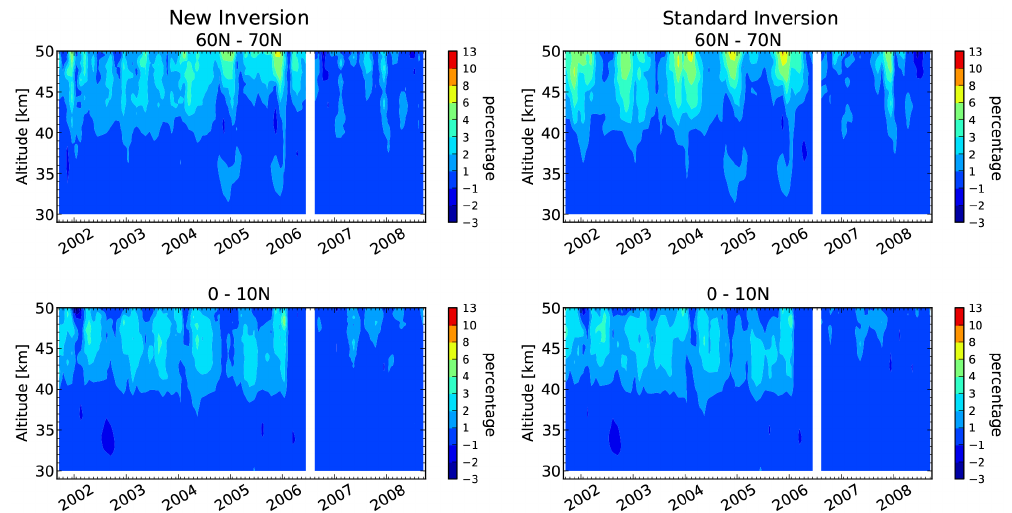
Figure 7. Relative differences between monthly mean refractivities from CHAMP data and from collocated ECMWF data, comparing new inversion (left) and standard inversion (right), for September 2001 until September 2008 and 10 ◦ zonal bins for northern mid- to low